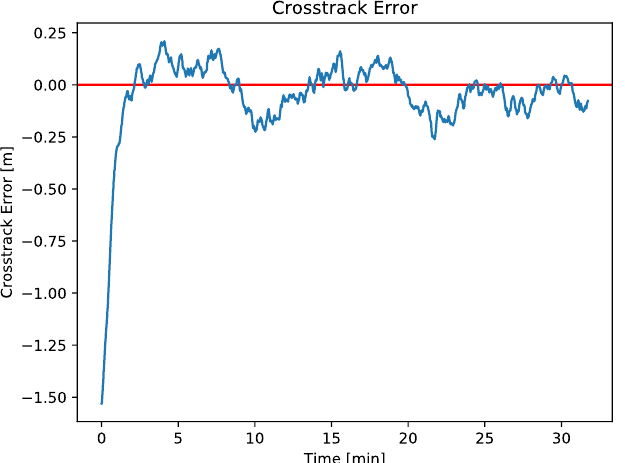
Figure 10. The green dashed line represents the programmed mission path, the blue line shows the navigation route achieved by the ASV.